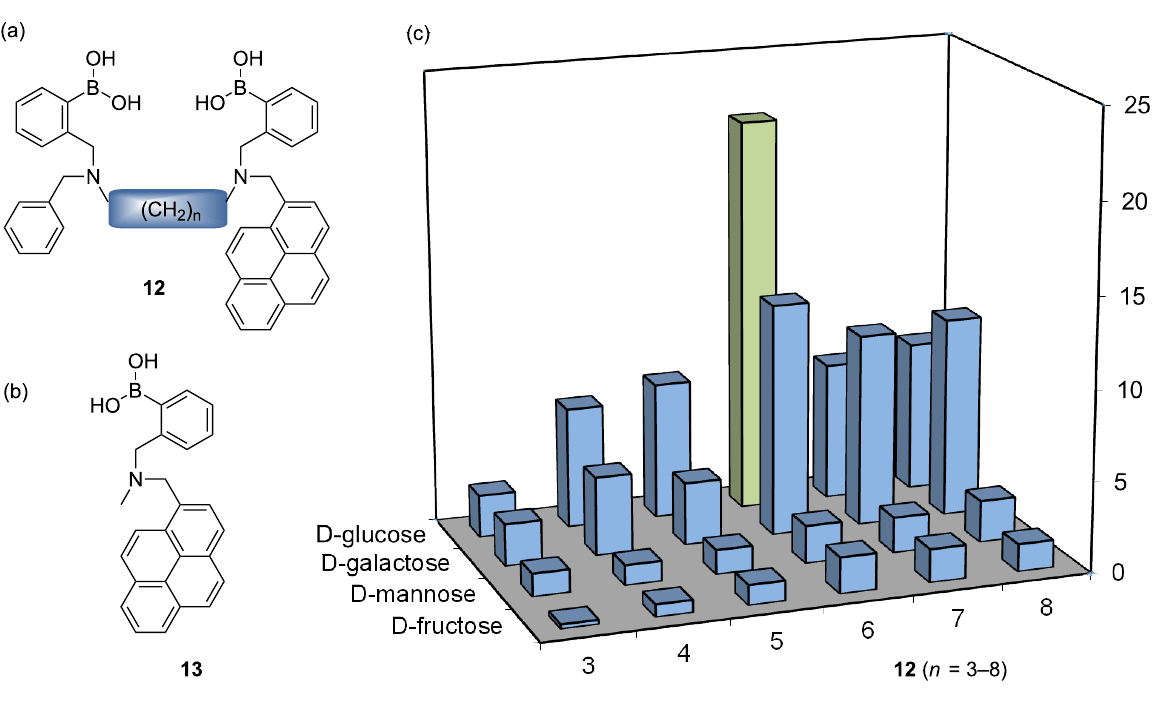
Figure 7: (a) Pyrene diboronic acids ( n = 3–8). (b) Pyrene monoboronic acid. (c) Block chart showing the relative stability K rel of saccharide com- plexes. Obtained from the observed stability constants ( K obs ) for D-glucose, D-galactose, D-fructose and D-mannose with pyrene diboronic acids ( n = 3–8) divided by the observed stability constants ( K obs ) with pyrene monoboronic acid, to yield relative values with saccharides .